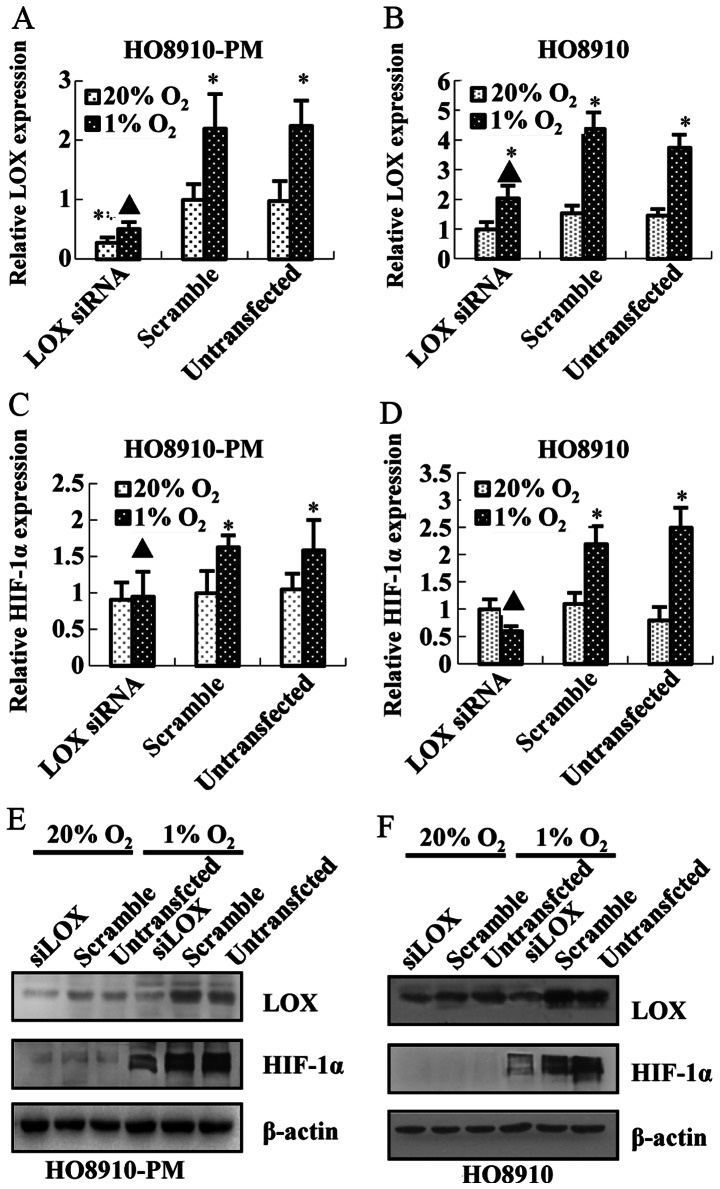
Effect of LOX on the regulation of HIF-1α expression in ovarian cancer cells cultured in normoxia or hypoxia. HO8910-PM and HO8910 cells were treated with siLOX, incubated for 24 h, and then exposed to normoxia (20% O2) or hypoxia (1% O2) for 24 h. Q-PCR of LOX mRNA expression in (A) HO8910-PM and (B) HO8910 cells. Q-PCR of HIF-1α mRNA expression in (C) HO8910-PM and (D) HO8910 cells; GAPDH was used as a reference gene; ▴P<0.05 vs. control untransfected cells or non-specific siRNA-transfected cells under hypoxia, *P<0.05 vs. 20% O2 control cells; ANOVA (n=3 replicates per group). Western blots of HIF-1α and LOX protein expression in (E) HO8910-PM and (F) HO8910 cells. Knockdown of LOX mRNA expression (A and B) using siLOX reduced HIF-1α mRNA expression in hypoxic cells; this effect was more obvious in (D and F) HO8910 cells than (C and E) HO8910-PM cells. Each experiment was performed at least three times.